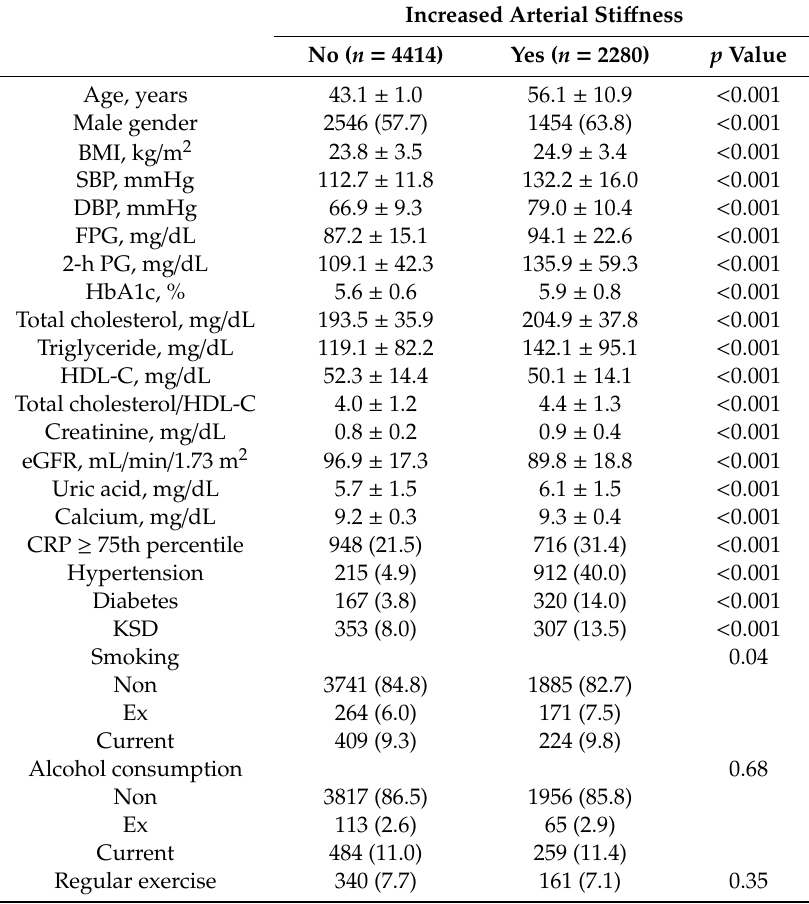
Table 1. Comparisons of clinical characteristics between subjects with and without increased arterial sti ff ness.